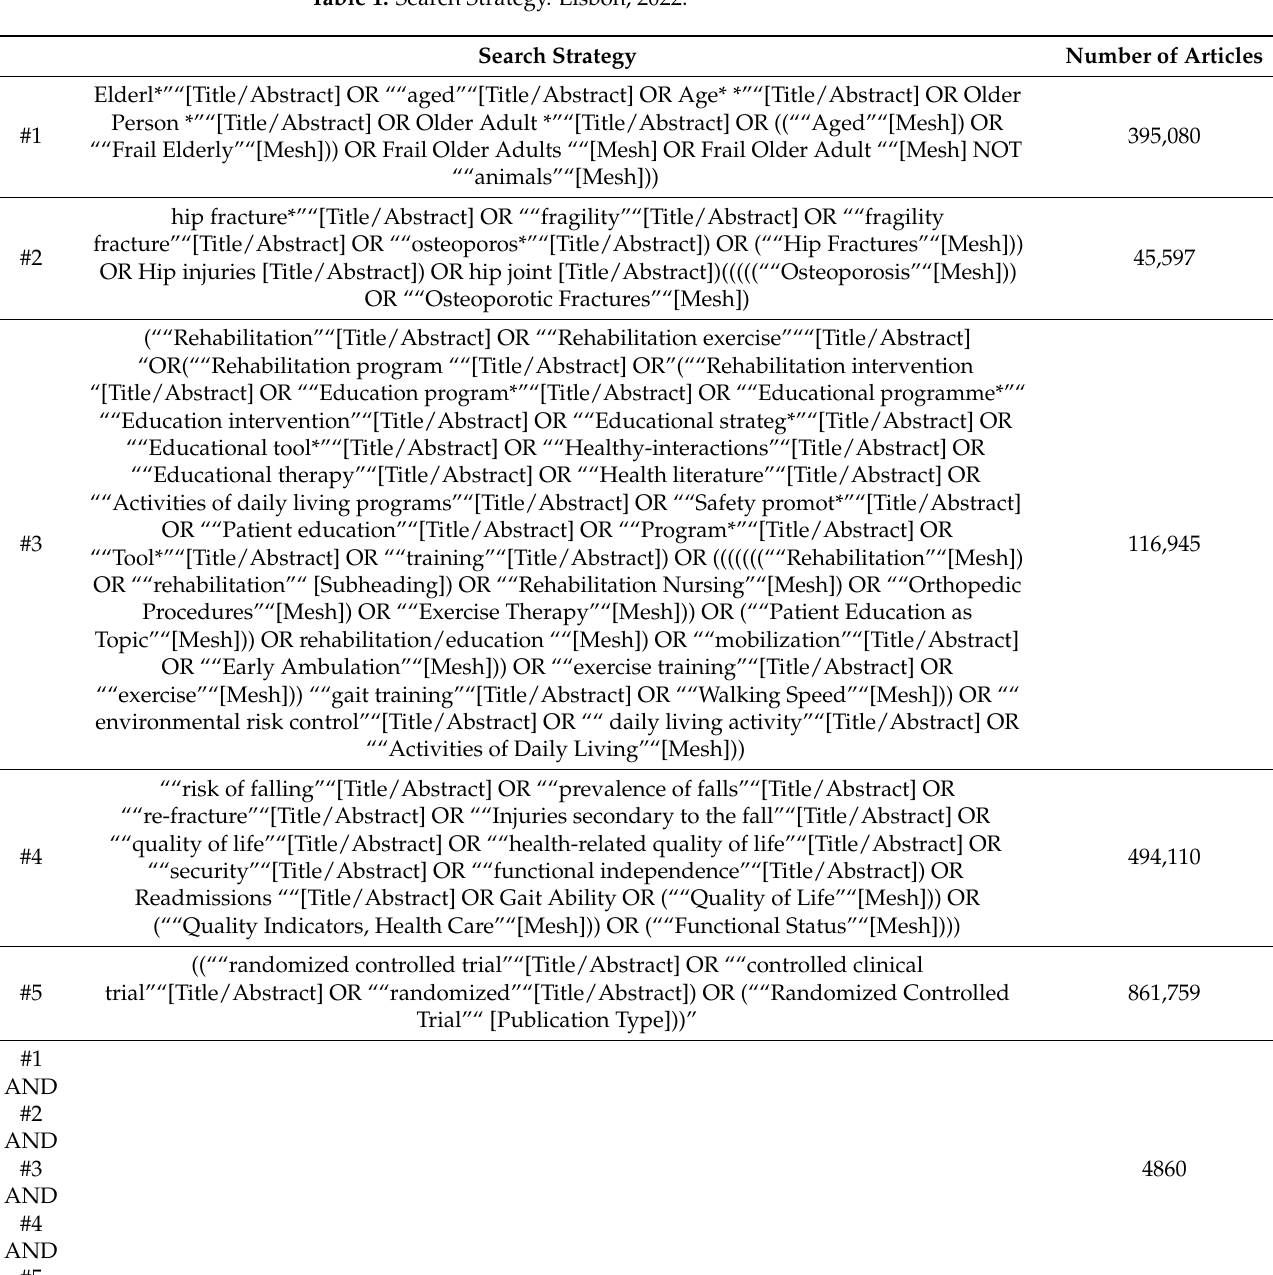
Table 1. Search Strategy. Lisbon,